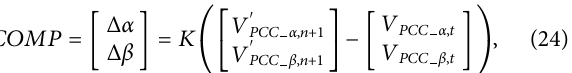
FIGURE 7 | Proposed method of the state controller for the cyber – physical system.